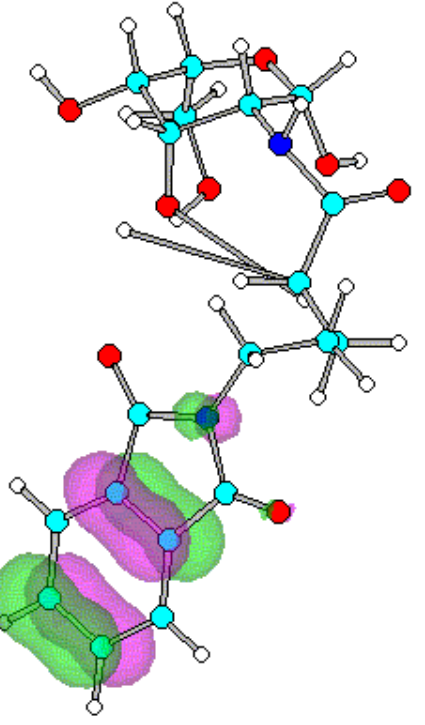
Figure 4. Optimized geometry and spatial distribution of HOMO for N-acyl-AG